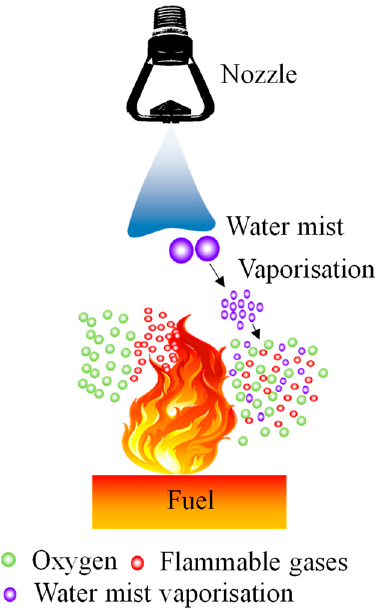
Figure 4. Heat extraction and water displacement of water mist system.